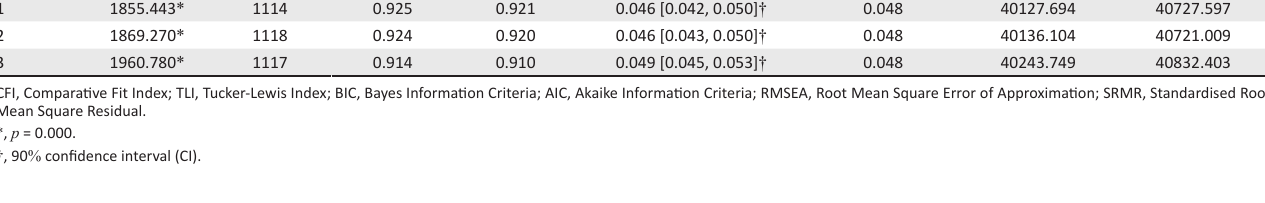
TABLE 2: Fit statistics of competing measurement models.